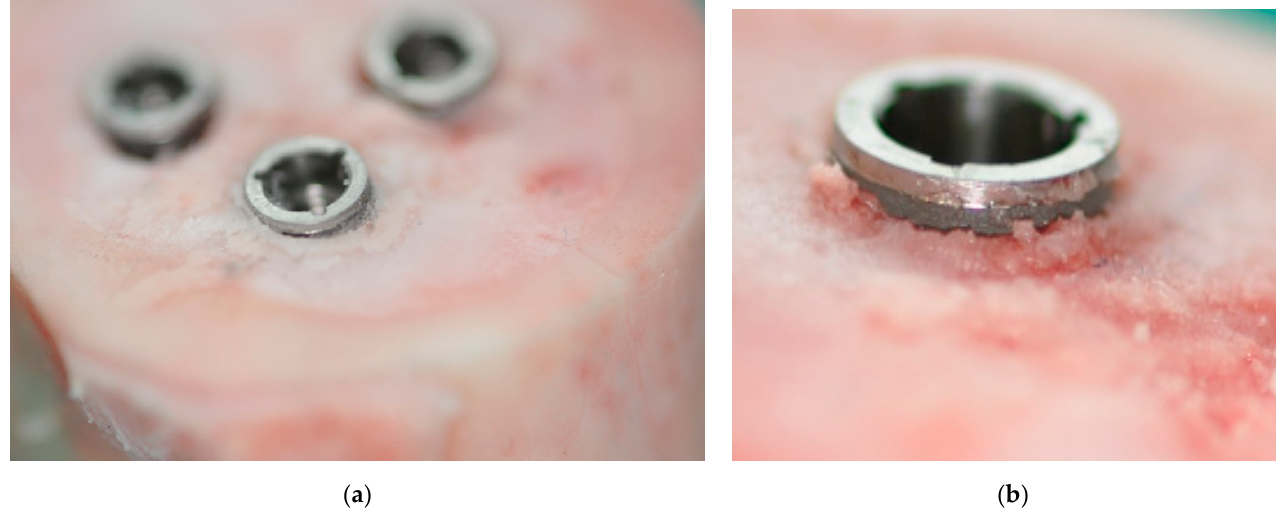
Figure 2. ( a ) Supracrestal insertion of three implants into a “soft” bone block. ( b ) Close-up of supracrestal insertion into a “soft” bone block.